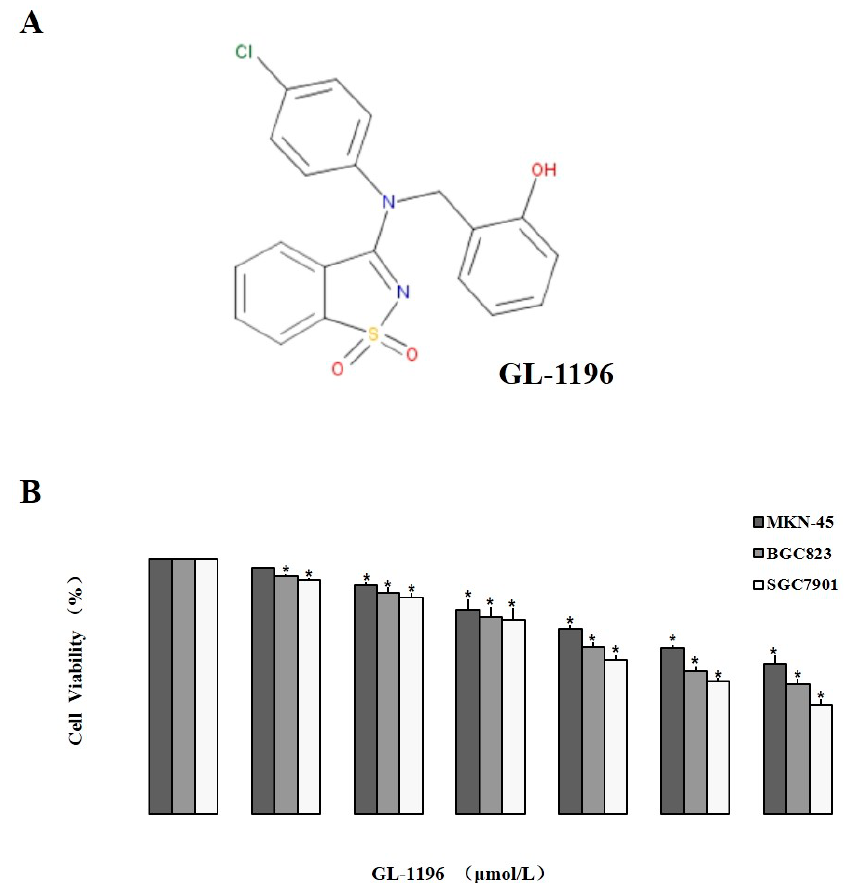
Figure 1. Chemical structure and the inhibitory proliferative effect on human gastric cancer cells of GL-1196. ( A ) chemical structure of GL-1196 (C 20 H 15 ClN 2 O 3 S); ( B ) the effect of GL-1196 on proliferation of human gastric cancer cells by MTT assay. The cell viability is shown as bar diagram ± SEM, * p < 0.05.